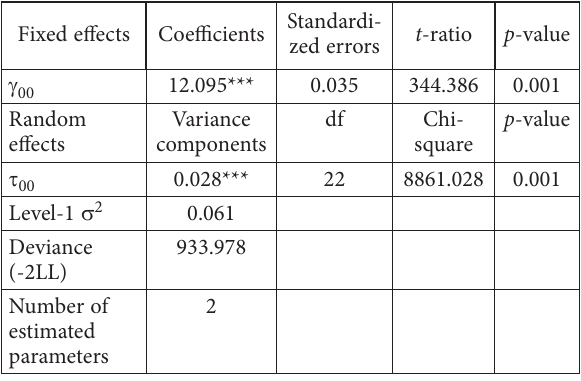
Table 3. Null model analysis